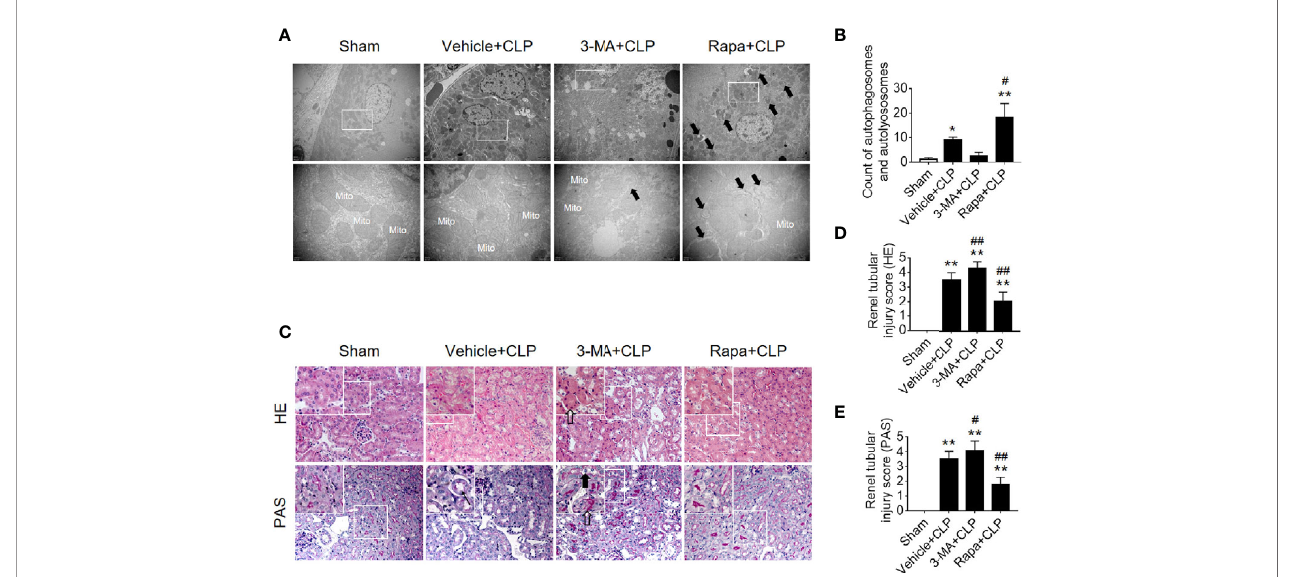
FIGURE 3 | Effects of autophagy regulation on renal pathology score and autophagy in CLP-induced sepsis. (A) Observation of autophagic structures in the renal cortex under a transmission electron microscope following autophagy regulation in septic mice. Black thick arrows: autophagosomes or autolysosomes; Mito, mitochondria; upper panel: magni fi ed ×7,000; lower panel: magni fi ed ×40,000. (B) Semi-quantitatively analysis of autophagy. The numbers of autophagosomes and autolysosomes in renal epithelial cells were calculated in 20 randomly selected fi elds. ** p < 0.05, ** p < 0.01 vs. sham group; # p < 0.05 vs. the vehicle + CLP group; n = 20. (C) Autophagy regulation on Hematoxylin-Eosin (HE) staining (upper panel: 200×; inset: 400×) and periodic acid-Schiff (PAS) staining (lower panel: 200×; inset: 400×) of the renal cortex following CLP-induced sepsis. Black thick arrows: Nuclei of RTECs shed to lumen; Long black arrows: tubular dilation; White thick arrows: severe tubular damage. (D, E) The tubular damage score was evaluated based on pathological observations from HE and PAS staining. * p < 0.01 vs. sham group; # p < 0.05, ## p < 0.01 vs. the vehicle + CLP group; n = 5. CLP, cecal ligation and puncture; RTEC, renal tubular epithelial